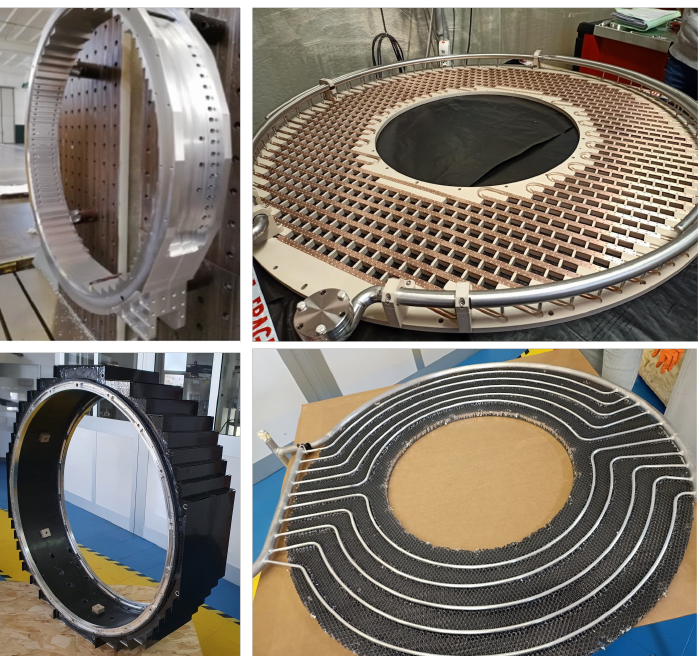
Figure 6. Calorimeter mechanical parts: ( top left ), outer ring; ( top right ), FEE plate; ( bottom left ), inner ring; ( bottom right ), front plate with source tubing embedded in the aluminium